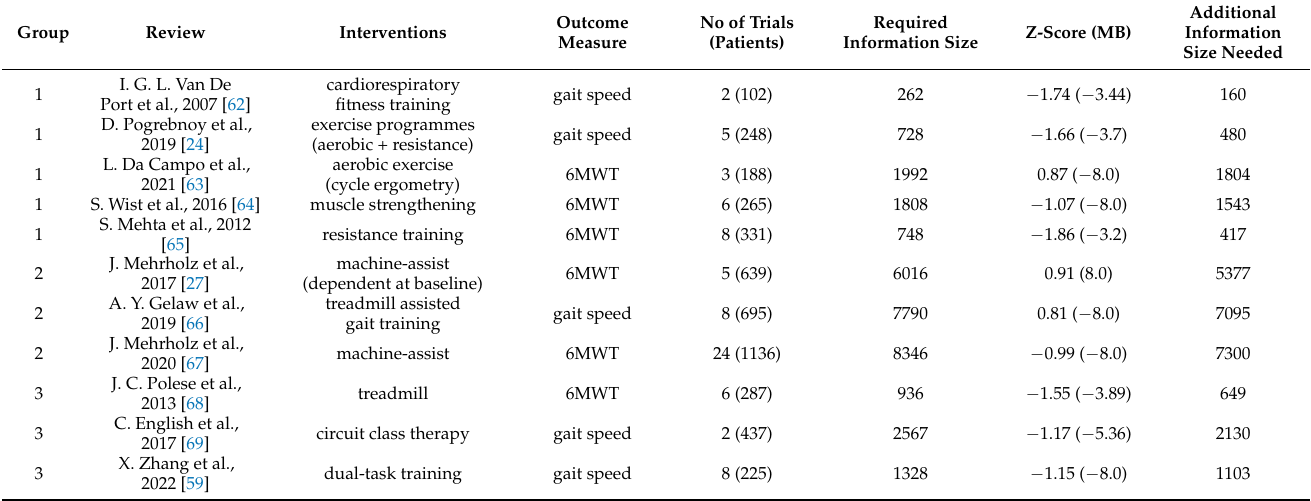
Table 6. Studies with absence of evidence on gait speed.